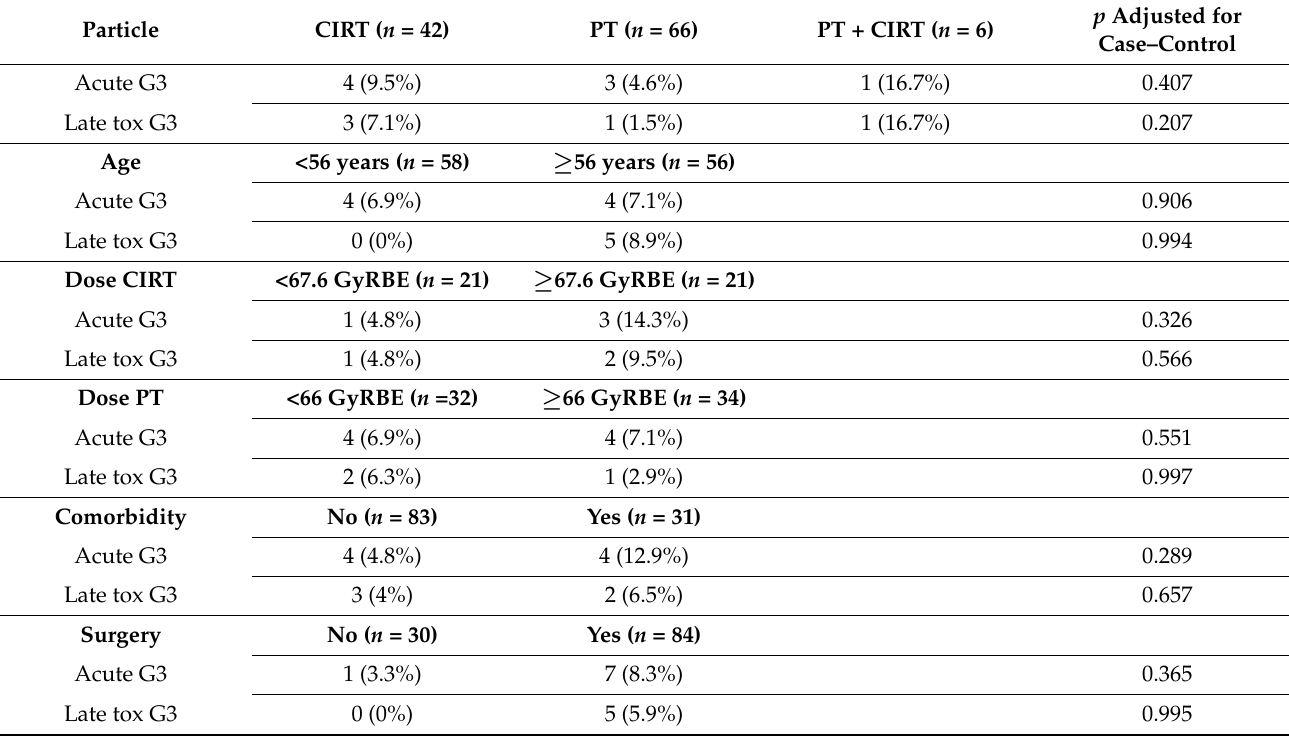
Table 5. Associations of grade 3 acute and late toxicity with clinical